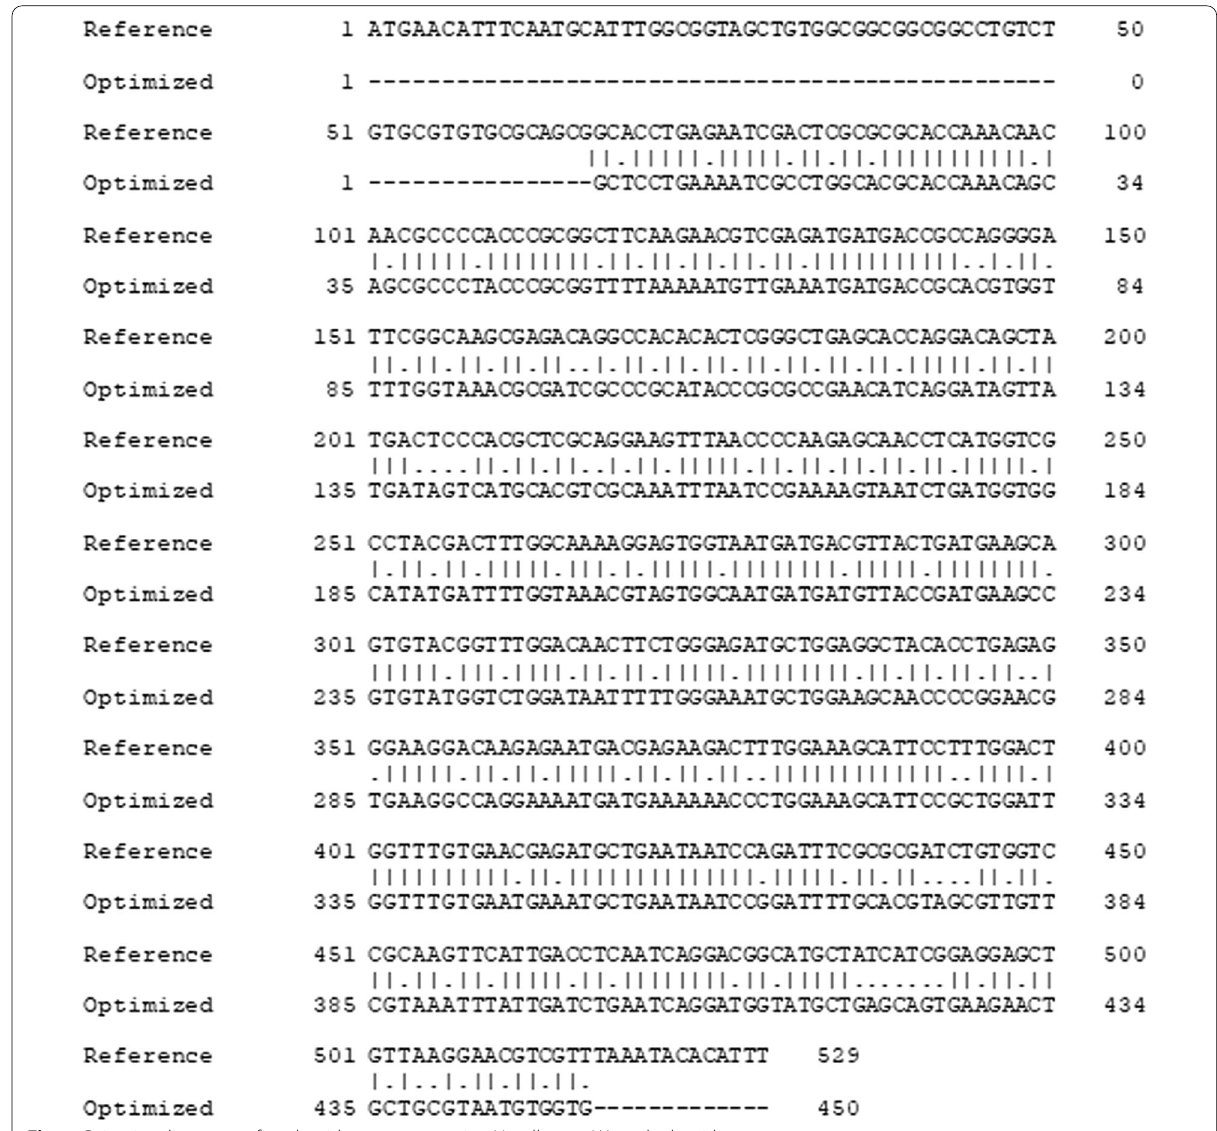
Fig. 1 Pair-wise alignment of nucleotide sequences using Needleman-Wunsch